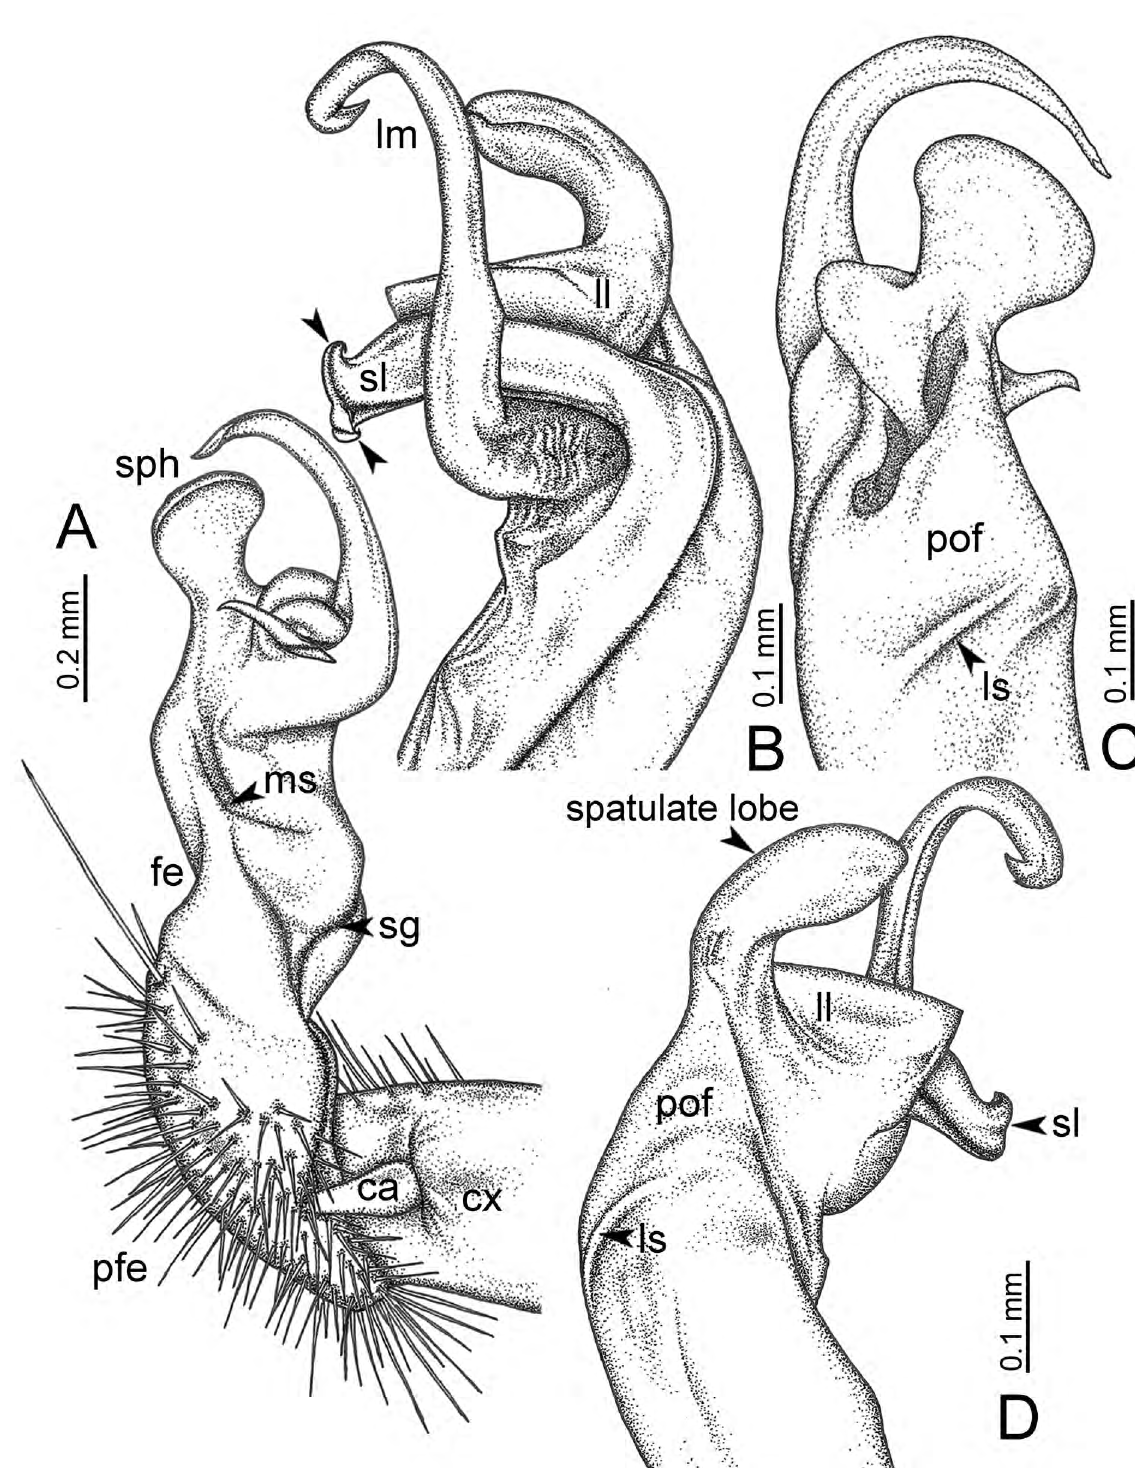
Fig. 25. Nagaxytes spatula Srisonchai, Enghoff & Panha gen. et sp. nov., paratype (CUMZ-pxDGT00121), right gonopod. A . Mesal view. B . Dorsal view (arrowheads = tip of solenomere terminating in two curved processes). C . Lateral view. D . Ventral